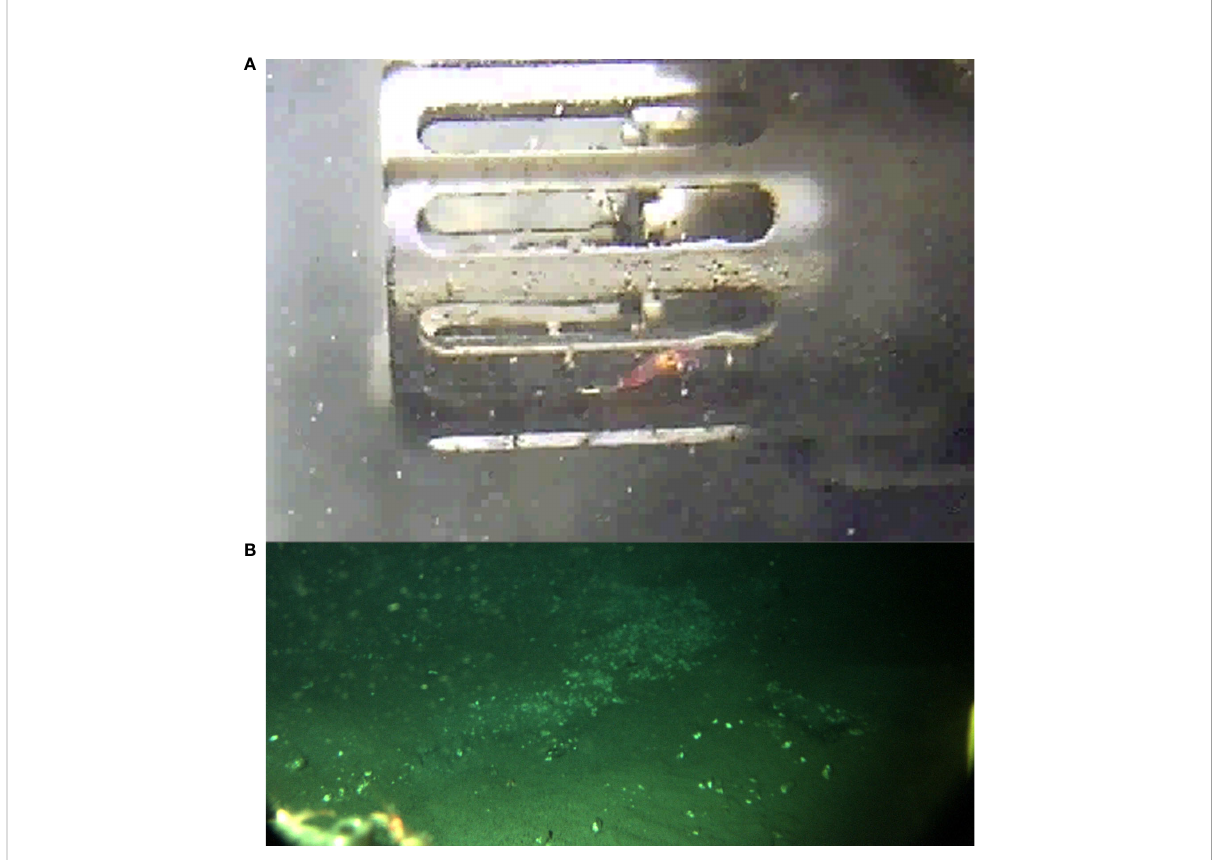
FIGURE 10 (A) Shrimp on the protective frame of an instrument (center). (B) Shrimps on the crawler ’ s frame (bottom left), being carried by the crawler during a transect mission (image taken on November 11 2016). Unfortunately, as they were observed a posteriori in images, the camera was focusing further away on the mission ’ s objective (i.e., hydrate mound ’ s